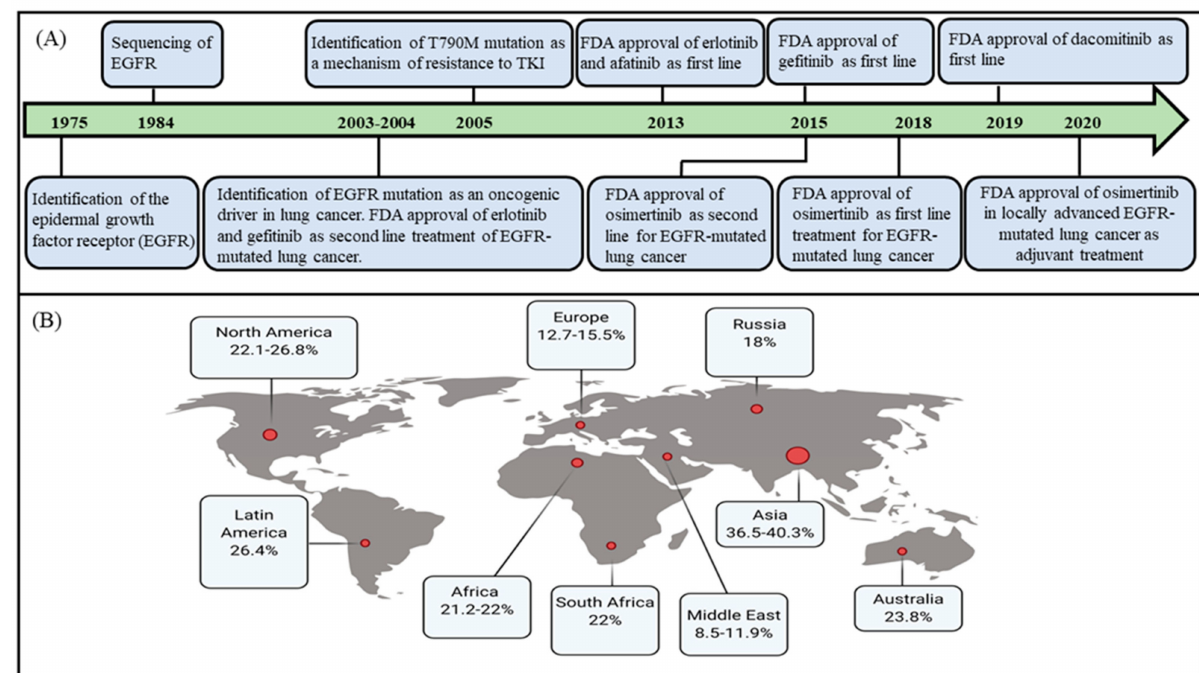
Figure 1. EGFR-mutated lung adenocarcinoma. Panel ( A ): A timeline of major developments in EGFR-mutated lung adenocarcinoma. Panel (B): The reported frequencies of EGFR mutations in lung adenocarcinoma based on geographic region: frequency in North America [29–31], Asia [27–29], Russia [32], South Africa [33], Middle East and Africa [34], Australia [35], and Latin America